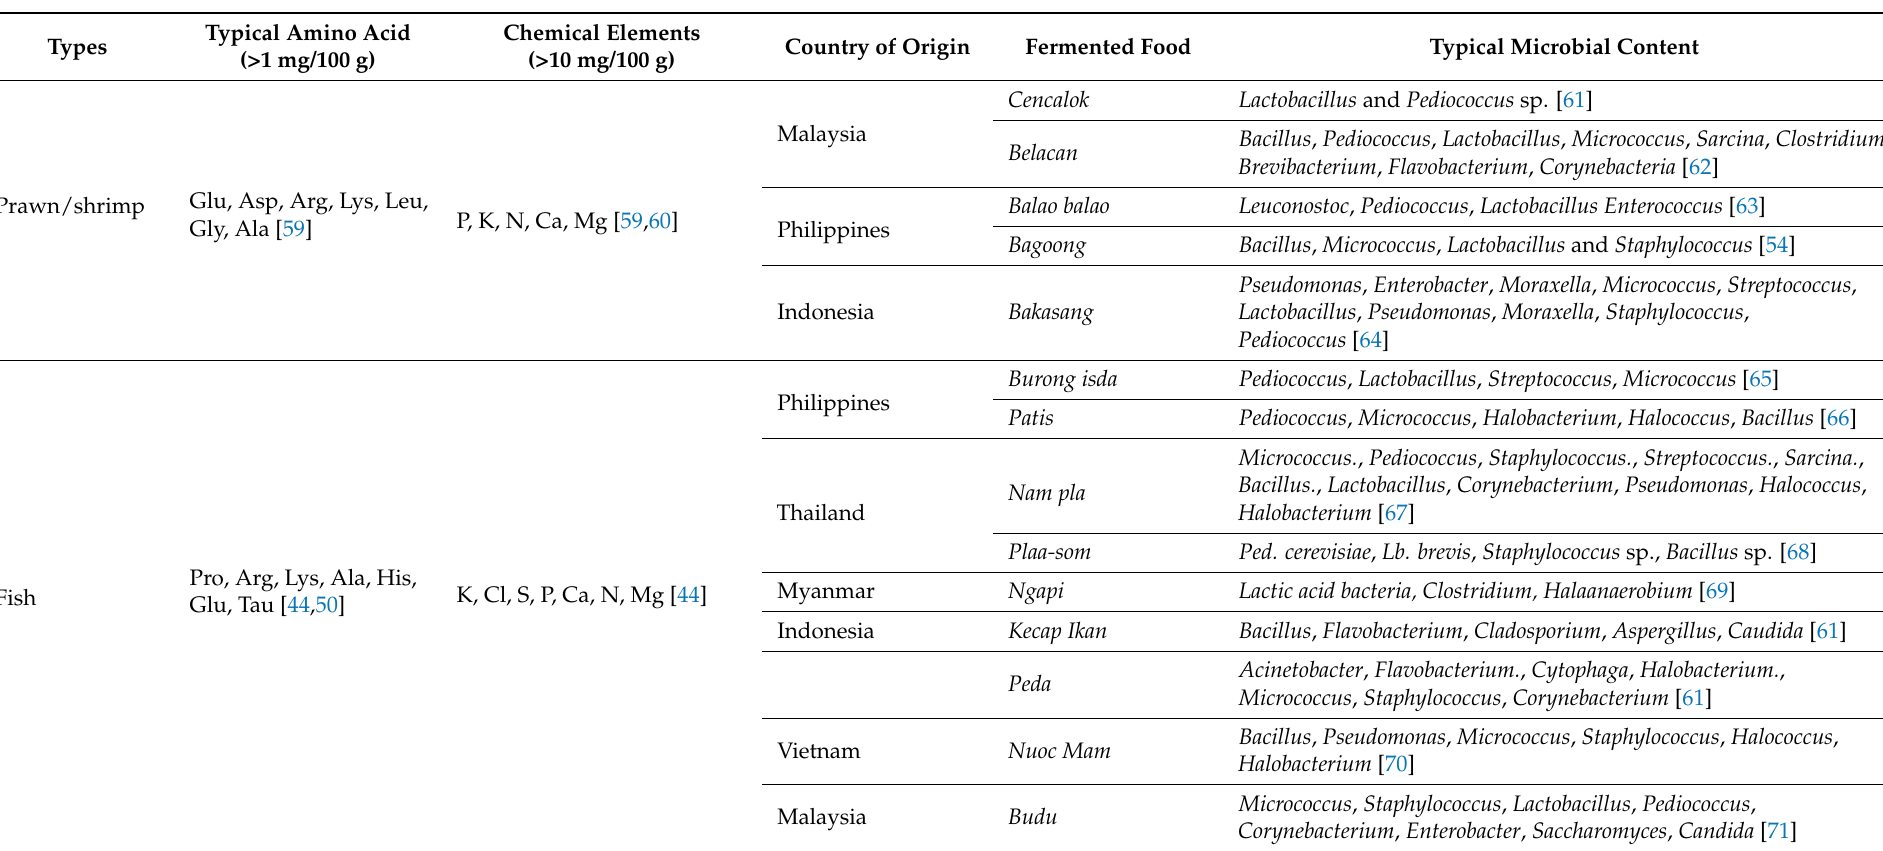
Table 2. Physicochemical and microbial content of seafood-based product from (a) prawn and (b) fish from different countries in Southeast Asia. Depending on the region, certain products can either use fish or prawn as their